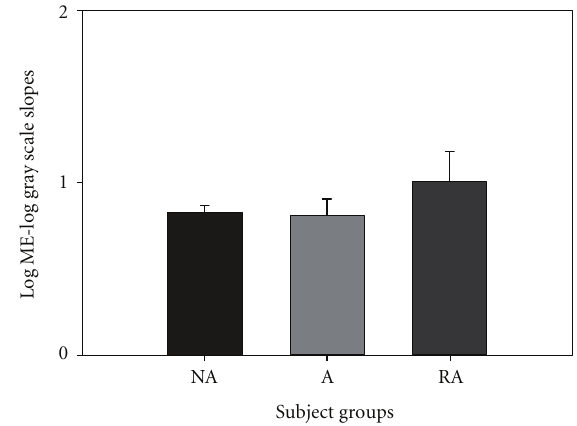
Figure 3: There was no significant di ff erence between the slopes for the 3 groups, NA, A, and LTA, for weight ME on log ME/log ounces scale.